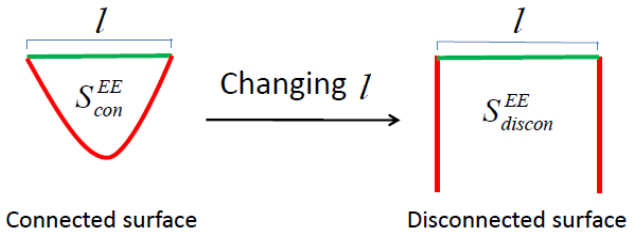
Figure 5 . Illustration of two minimal area surfaces corresponding to one strip of length ‘ in the thermal-AdS background. A phase transition from connected to disconnected surfaces takes place as the length of the strip